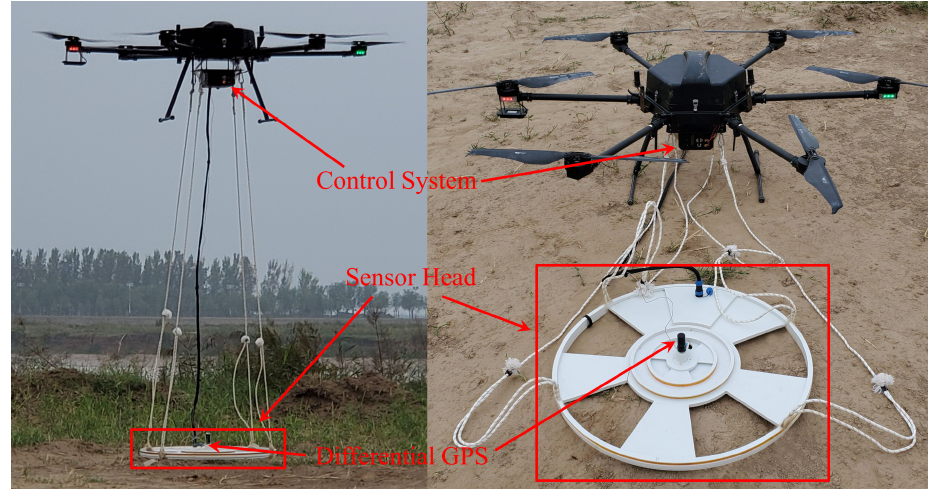
Figure 11. The AFEM-3